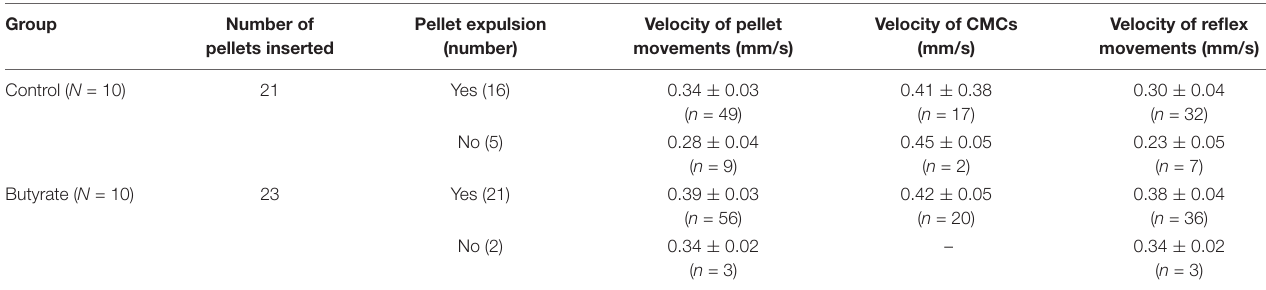
TABLE 4 | Velocities of motor patterns in the control and butyrate